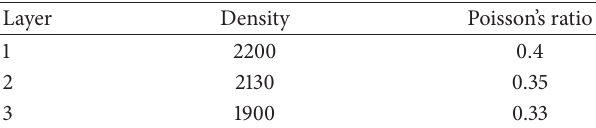
Figure 9: Resonant frequency of phase spectrum at transfer func- tion. Table 1: The parameters used in the